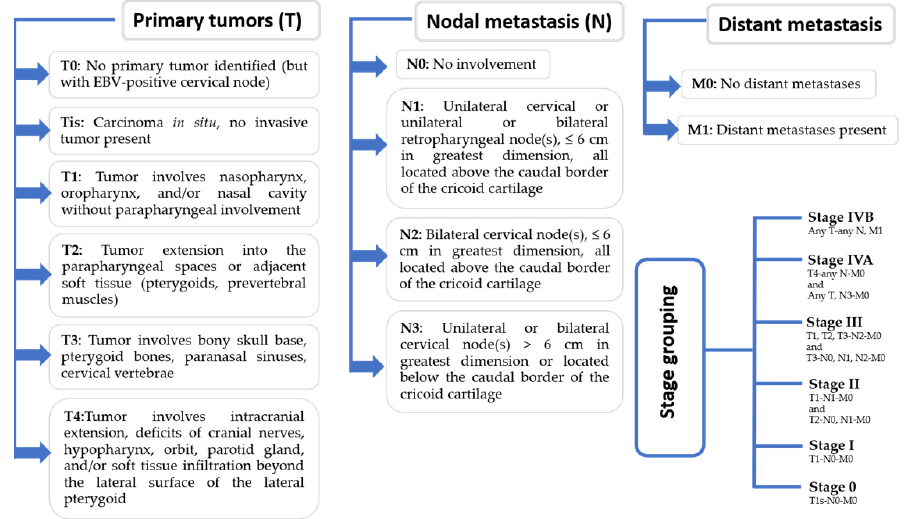
Figure 1. The tumor node metastasis (TNM) staging for nasopharyngeal carcinoma (NPC).